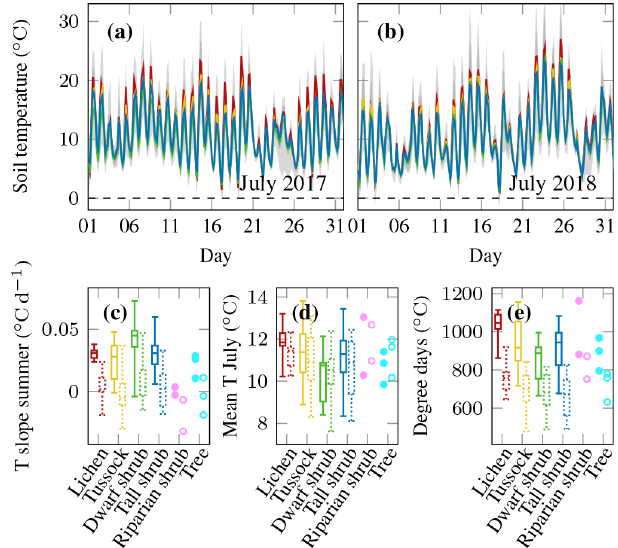
Figure 9. Topsoil temperature series of (a) July 2017 and (b) July 2018 representing summer of the two different measurement periods; mean of all measurements below the four different vegetation types is shown in colour, the range of all single sensors is shown in light grey, and the range of all sensors between the 10th and 90th percentiles is shown in darker grey; box plots show all measurements per vegetation type with boxes of the first period on the left and the second period on the right and dotted; for riparian shrubs and trees all single observations are shown with filled symbols for the first period and open symbols for the second; (c) rate of warming in summer; (d) mean July temperature; (e) cumulative sum of positive degree days until the end of